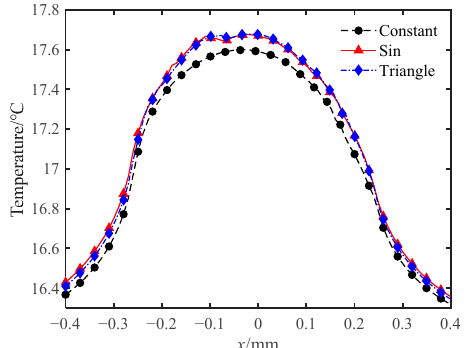
Figure 14. Variation law of temperature distribution with normal load.